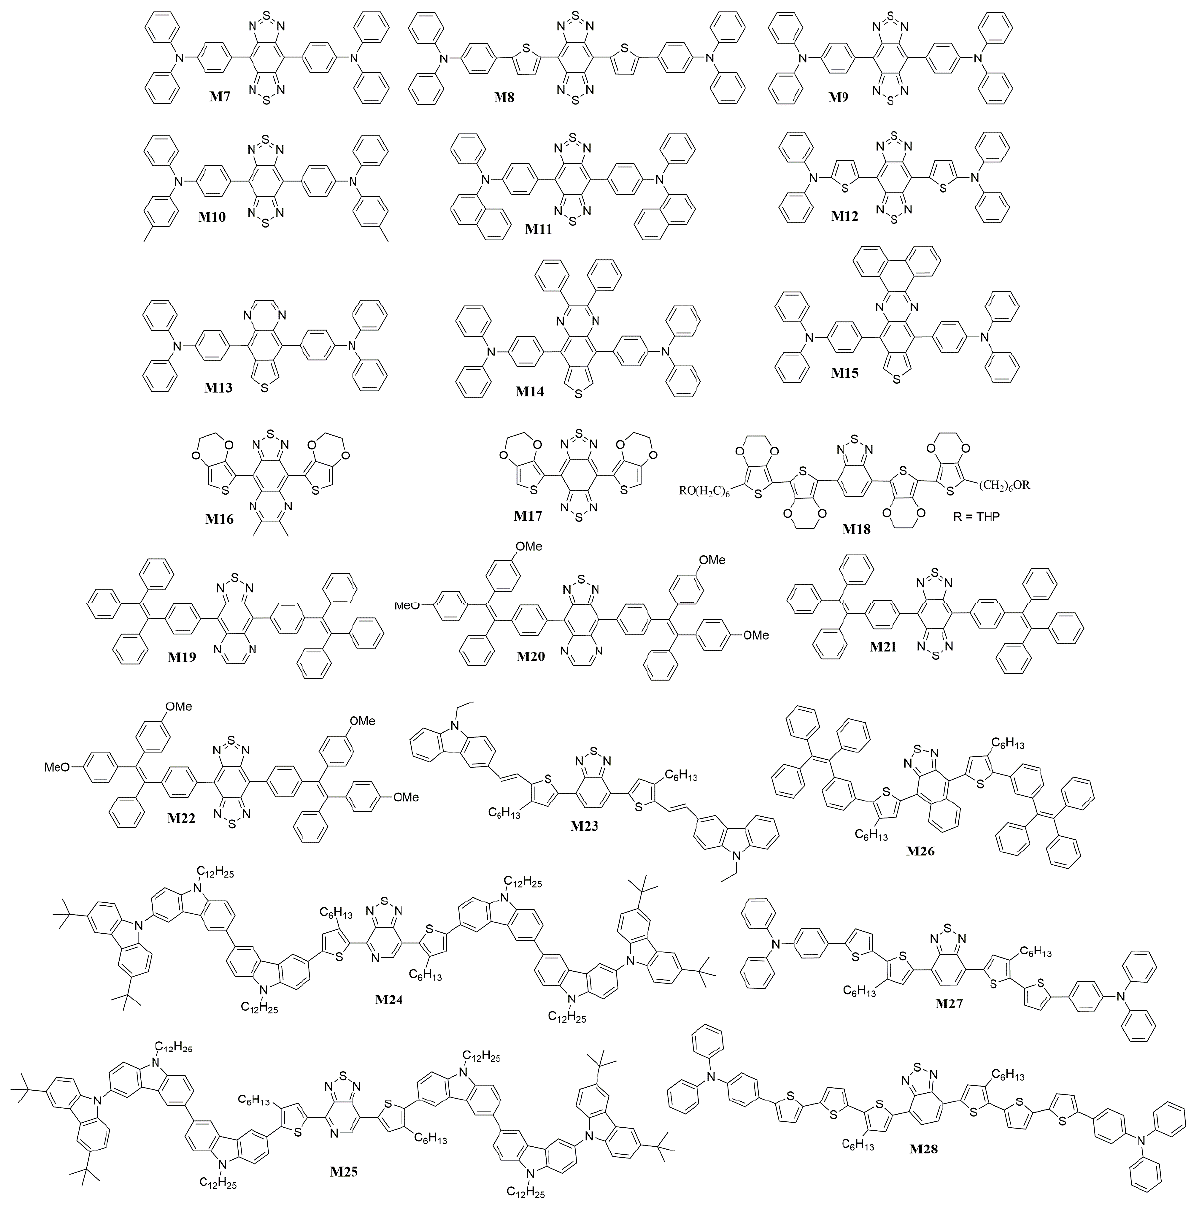
Figure 10. Chemical structures of M7 to M28 .